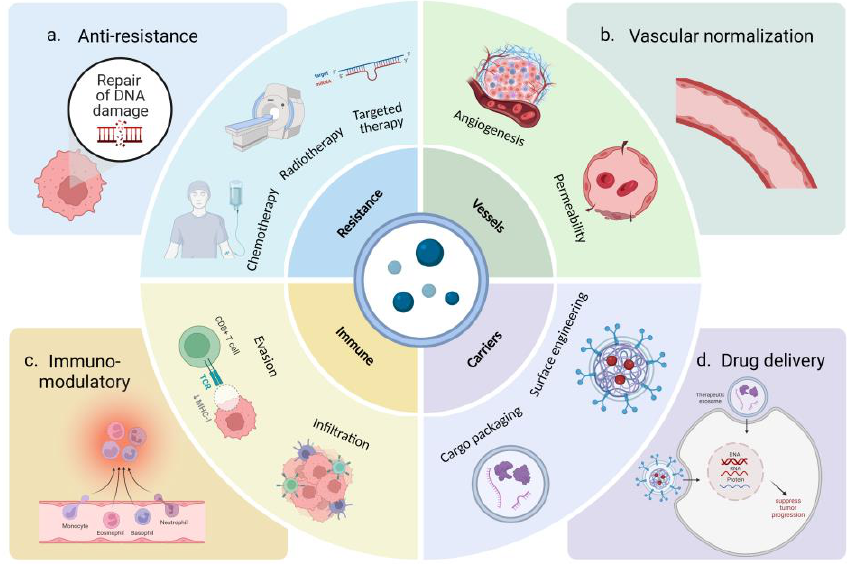
Figure 2. Principles and applications of sEVs in cancer therapy. ( a ) sEV contents induce chemo [14], radiation [16], and targeted therapy resistance [17] by changing the sensitivity of recipient cells through intercellular communication; ( b ) sEVs can regulate angiogenesis [17,18] and vascular permeability [19,20] by influencing the behavior of endothelial cells that line blood vessels; ( c ) sEVs can regulate the evasion [21] and infiltration [22] of immune cells by stimulating or suppressing immune responses, that is, they have the ability to act as immunomodulators [23]; ( d ) direct incubation of sEVs with cargo [24] or sEVs with surface engineering [25] can achieve the function of therapeutic cargo packing and targeted therapy (Created with https://www.biorender.com/ (accessed on 26th February 2023)).